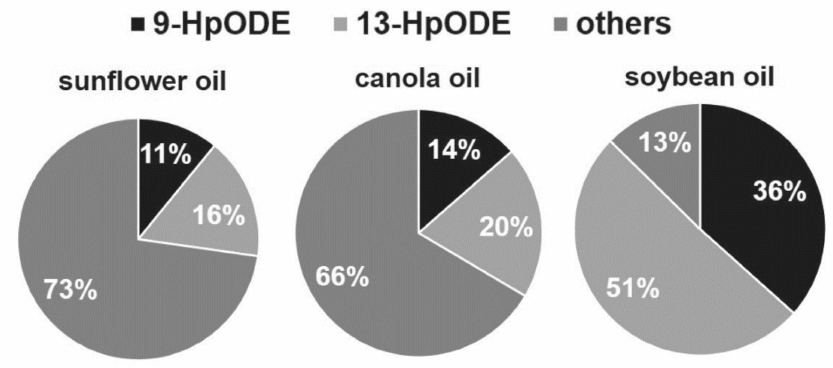
Figure 16. Percentage of 9-hydroperoxy octadecadienoic acid (9-HpODE) and 13-HpODEon total peroxides formed in sunflower, canola, and soybean oil stored under household conditions for 56 days. Data are expressed as the mean ( n = 3)